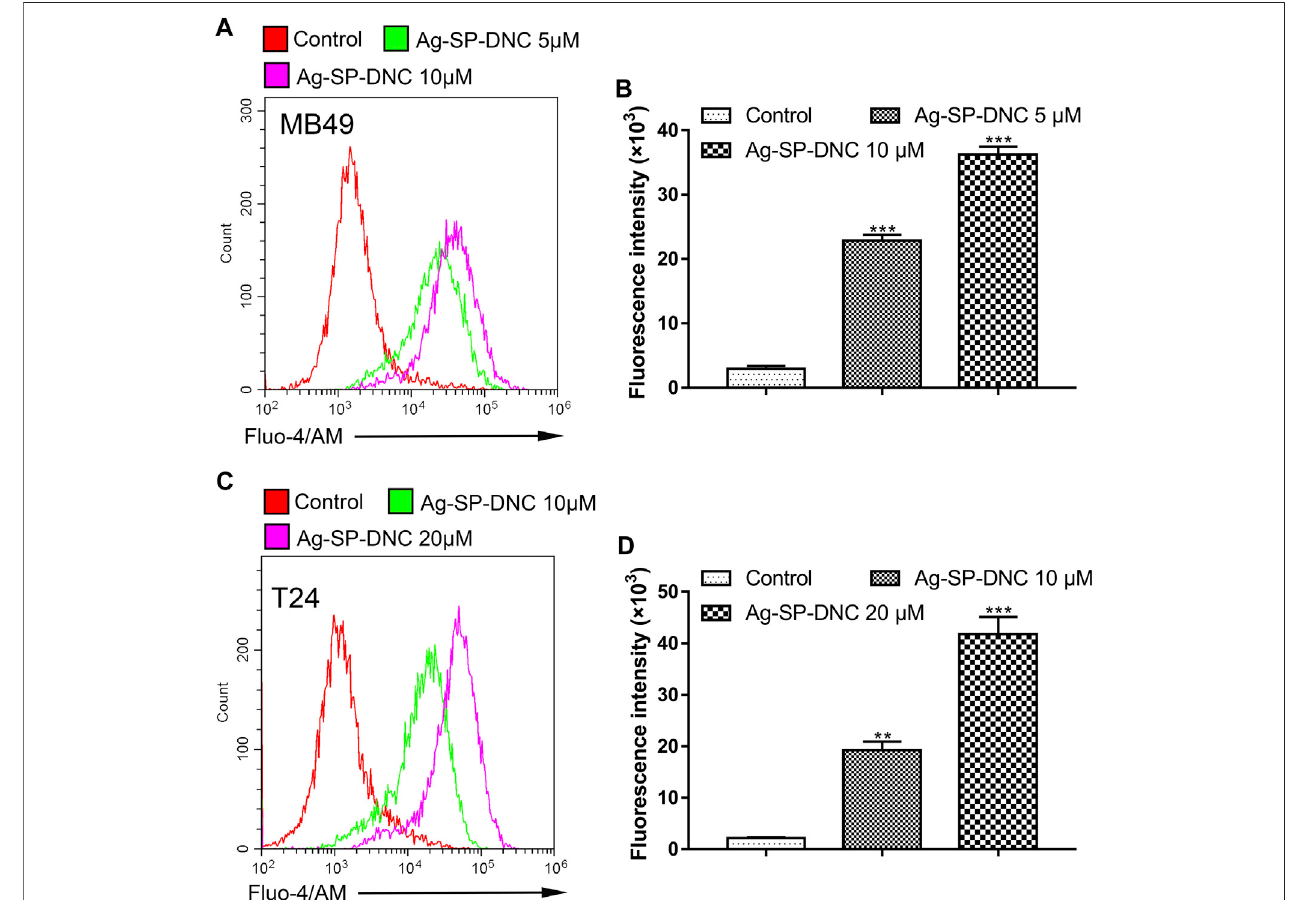
FIGURE 8 | Ag-SP-DNC induces bladder cancer cells intracellular free Ca 2+ release. Bladder cancer cells were treated with Ag-SP-DNC for 24 h. The levels of intracellular free Ca 2+ were measured by Fluo-4/AM staining and fl ow cytometric analyses. (A , B) Intracellular free Ca 2+ of MB49 cells were measured by fl ow cytometry. (A) Representative histograms were shown. (B) Cell associated mean relative fl uorescence intensities. Dataare mean ± SEM; n (cid:1) 3. *** p < 0.001. (C , D) Intracellular free Ca 2+ of T24 cells were measured by fl ow cytometry. (C) Representative histograms were shown. (D) Cell associated mean relative fl uorescence intensities. Data are mean ± SEM; n (cid:1) 3. ** p < 0.01, *** p <